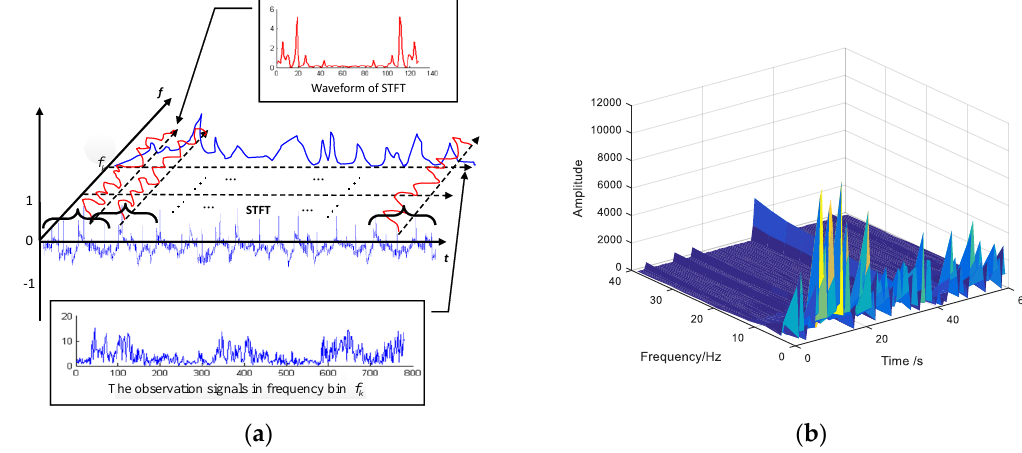
Figure 5. Time-frequency features extraction. ( a ) Demonstration of acquiring the frequency-domain observation vectors; ( b ) Time-frequency diagram after STFT.